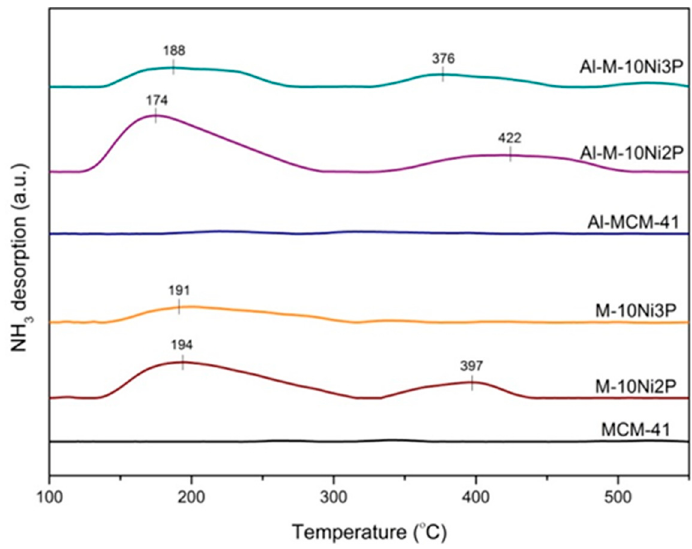
Figure 5. NH 3 -TPD profiles of the synthesized materials.